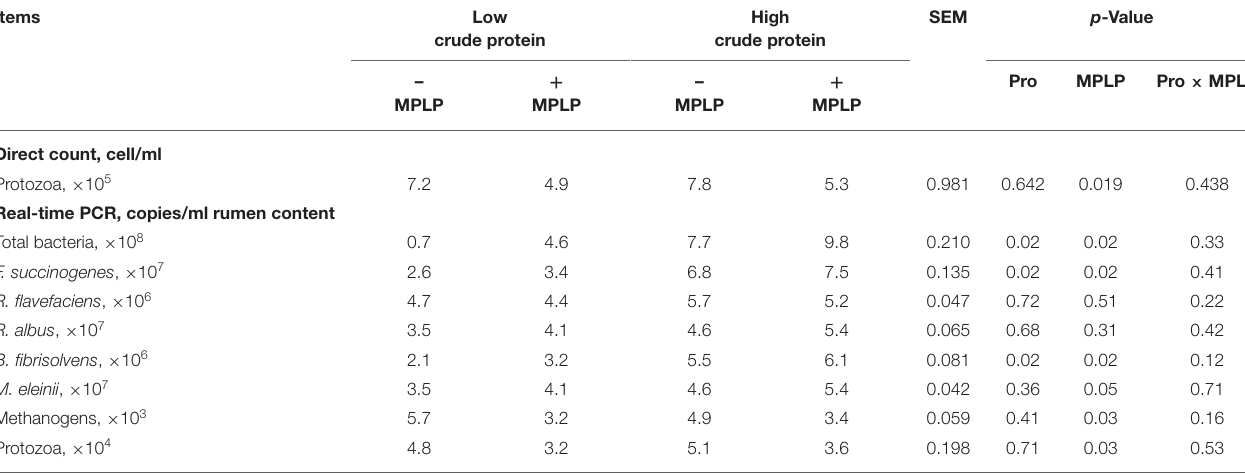
TABLE 4 | Effect of crude protein level and mangosteen peel liquid-protected soybean meal on rumen microbial population in lactating dairy cows. Items Low